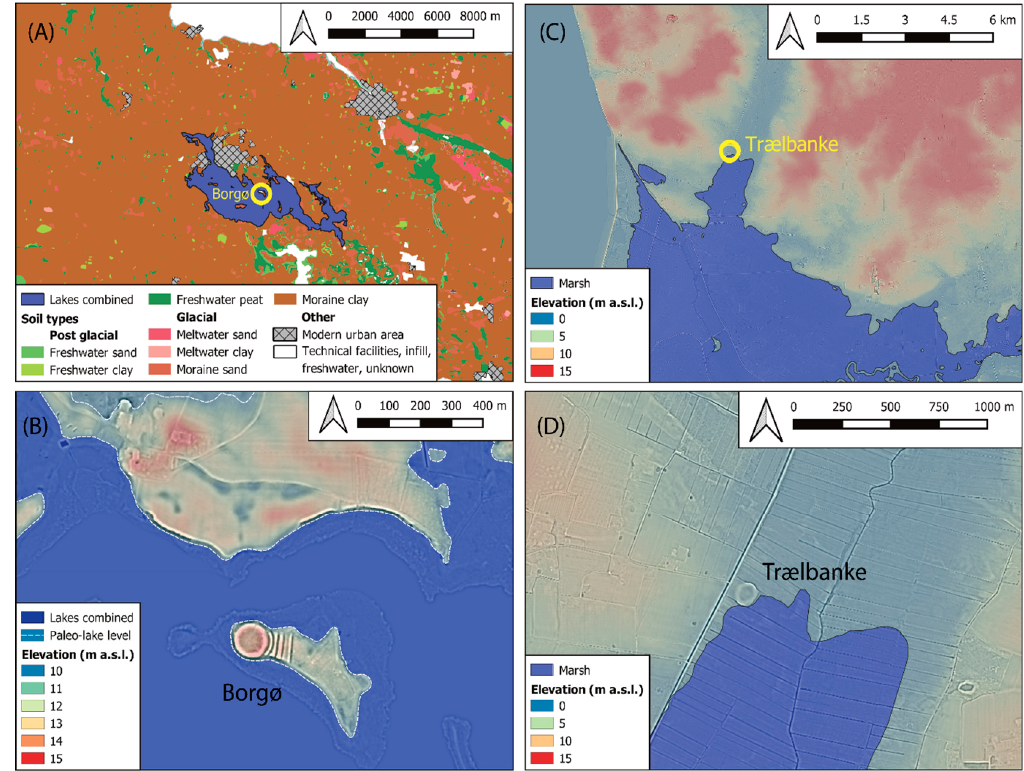
Figure 9. Suggestions for paleo-landscapes at the two candidate sites in the late Viking-Age Borgø ( A ) and Trælbanke ( B ) as regional overviews based on a false-color digital elevation model below a transparent residual relief visualization. At Borgø, the blue signature depicts a likely paleo-lake level before a major drainage of the Maribo lakes [81] with present-day then flooded areas around the Borgø site as shading in the blue ( C ). At Trælbanke, the blue signature is marsh sediments (Danish Geological Surveys Soil Map 1:25,000), showing where thickness of storm-flood generated Wadden Sea tidal sediments are greater than approximately 90 cm today ( D ).